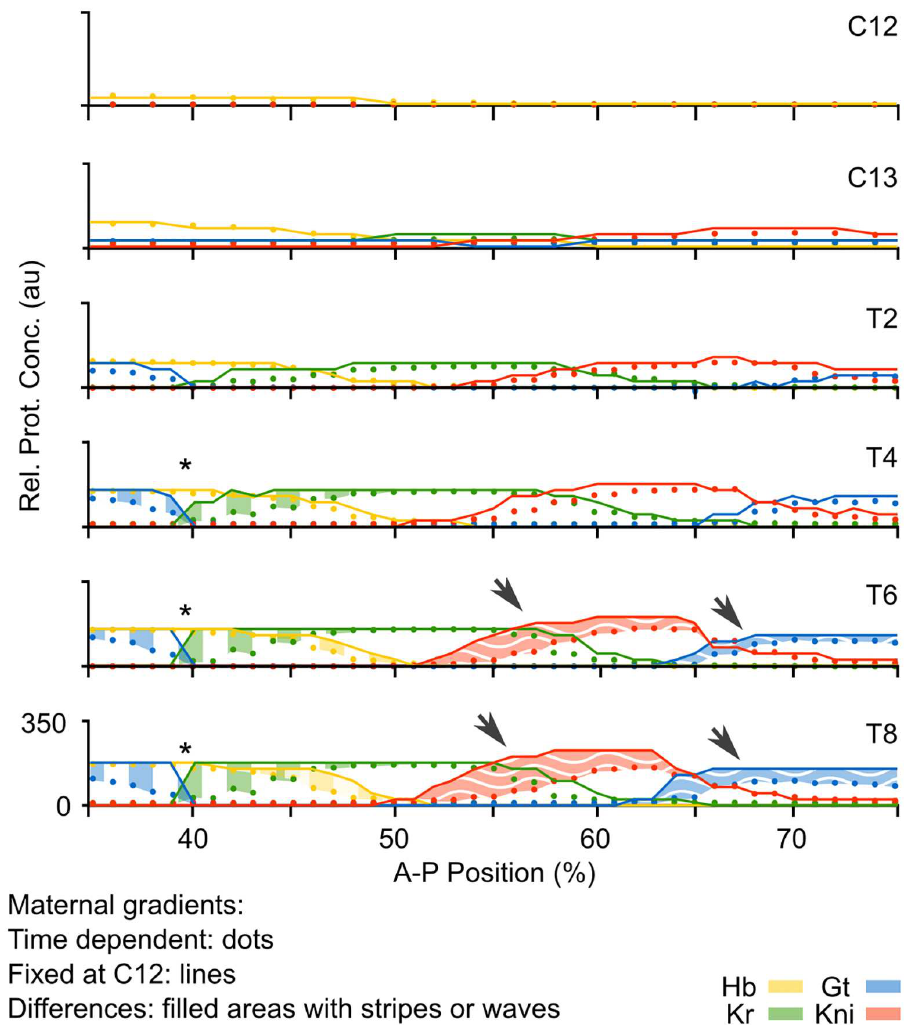
Fig 4. Effect of the time-dependence of maternal gradients on gap gene pattern formation. (A) Plots show output from the non-autonomous gap gene circuit with time-variable maternal gradients(dots), comparedto output from the same model with maternalgradientsfixed to their values at cycle C12 (early blastoderm stage; lines). Y-axes represent relative protein concentrations in arbitrary units (au); x-axes represents %A–P position,where 0% is the anterior pole. Differencesbetweenthe two model simulations are shadedusing vertical stripes in the anterior trunk region, and wavy horizontal stripes in the posterior. Asterisks mark over-expression in the regionof the Gt/Kr interface; arrows mark “overshoot” of gap domainshifts in the posterior of the